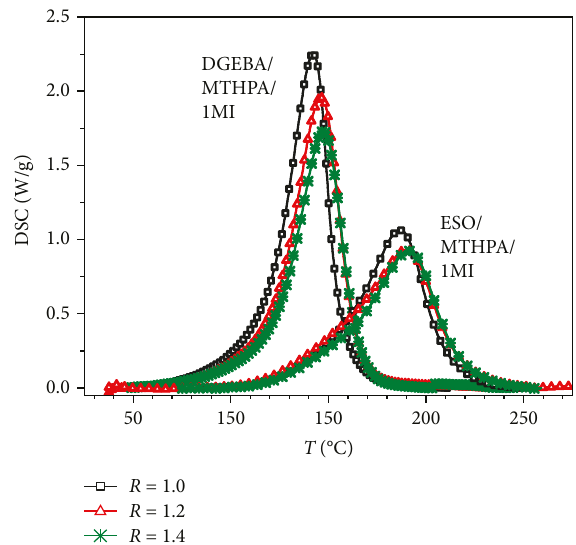
Figure 2: DSC thermograms for the curing of DGEBA and ESO with MTHPA and 1MI with di ff erent stoichiometric ratios R , at a heating rate q = 10 ° C/min